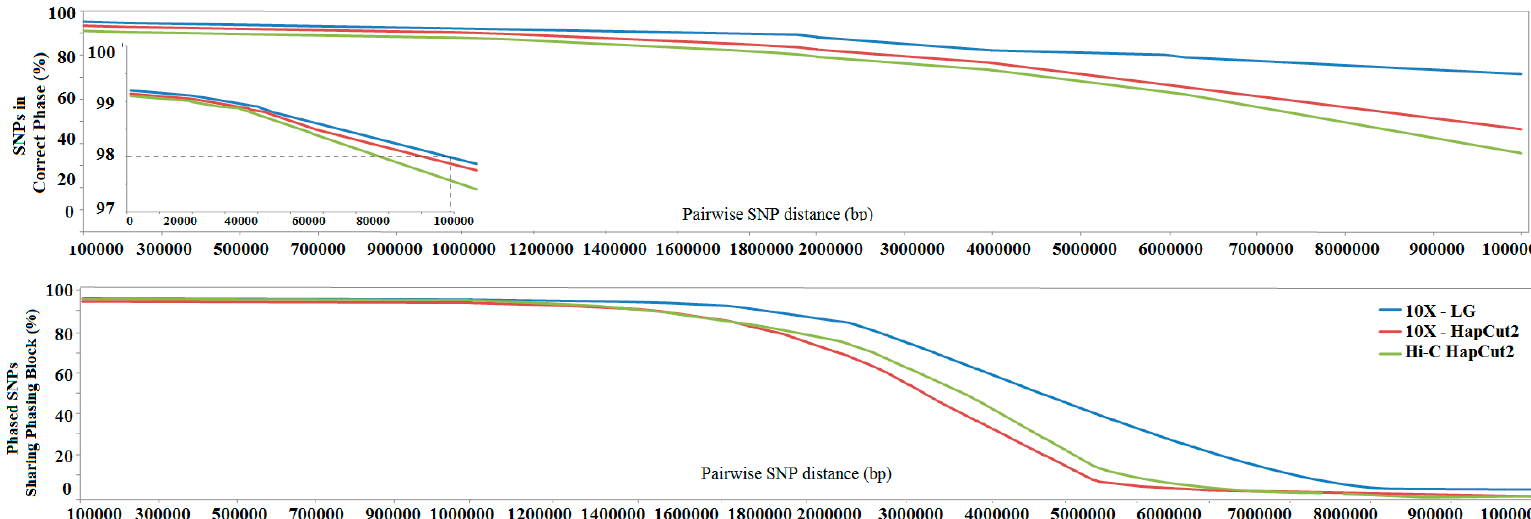
Figure 2. Comparison of phasing performance pairwise haplotype assignment: ( a ) Phasing accuracy shows the effect of distance on probability that SNPs on the same phasing block are correctly phased. ( b ) Phasing yield shows the effect of distance between a pair of SNPs on the probability that they are phased in the same phasing block.